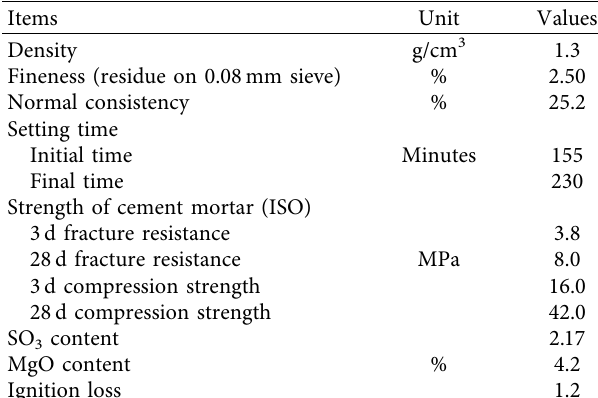
Figure 1: Particle grading analysis curve for muddy clay and fine sand. Table 1: Properties of the ordinary Portland